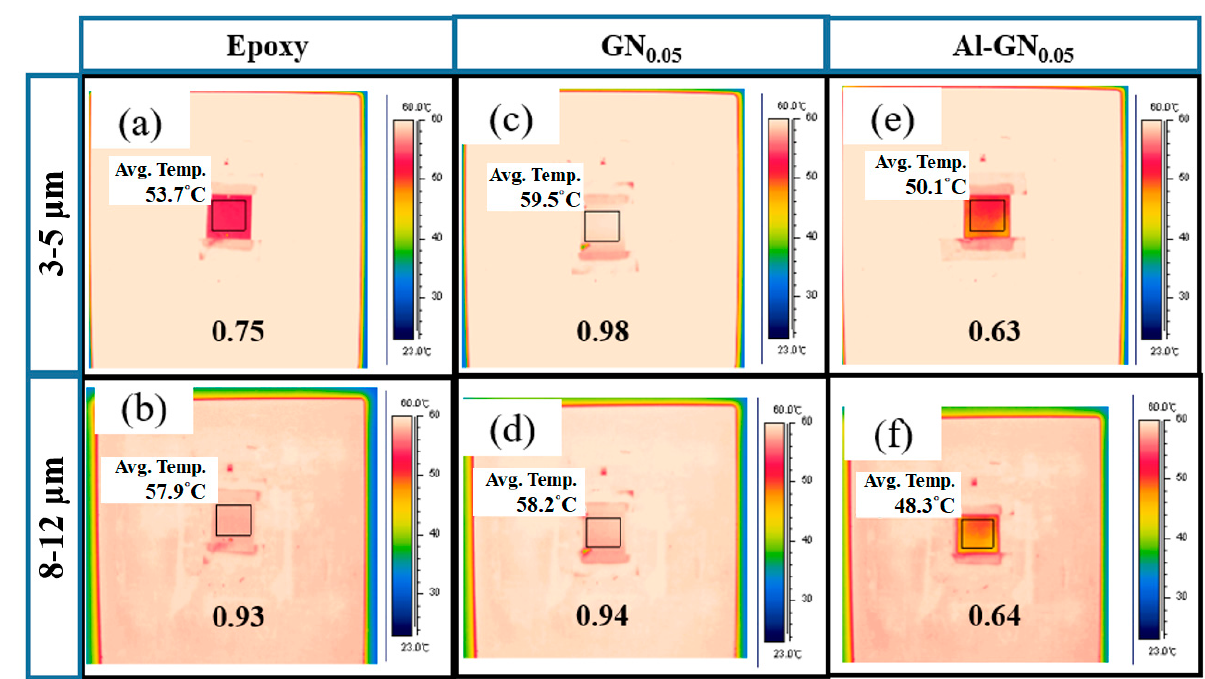
Figure 18. IR images (with average thermal emissivity values and average temperatures) in the 3–5 μ m and 8–12 μ m windows for ( a , b ) the neat epoxy, ( c , d ) GN 0.05 -epoxy and ( e , f ) Al 25 -GN 0.05 -epoxy coatings.